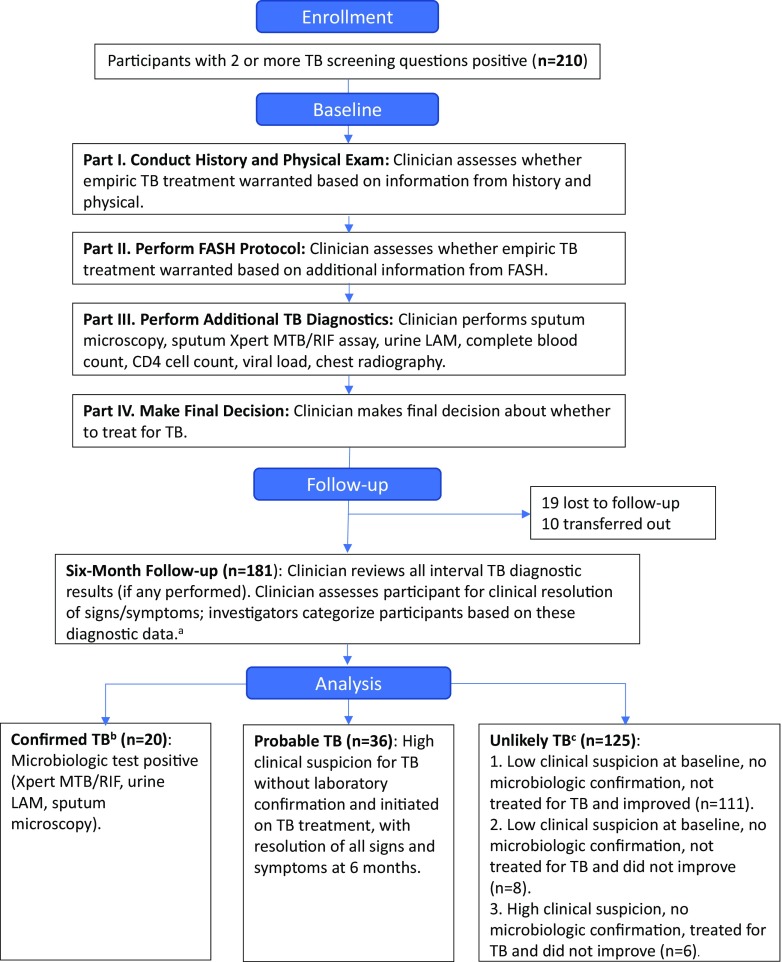
Participant Enrollment in a Prospective Cohort Study Assessing Diagnostic Utility of FASH at an Urban Medical Center, Lilongwe, Malawi, and Clinicians' Stepwise Diagnostic Evaluation and Decision MakingAbbreviations: FASH, focused assessment with sonography for HIV-associated tuberculosis; LAM, lipoarabinomannan; MTB, Mycobacterium tuberculosis; RIF, rifampicin; TB, tuberculosis.aFinal categorization made by study investigators based on 6-month data and definitions above.bIncludes 2 deaths.cIncludes 12 deaths: 7 in Subgroup 2 and 5 in Subgroup 3.